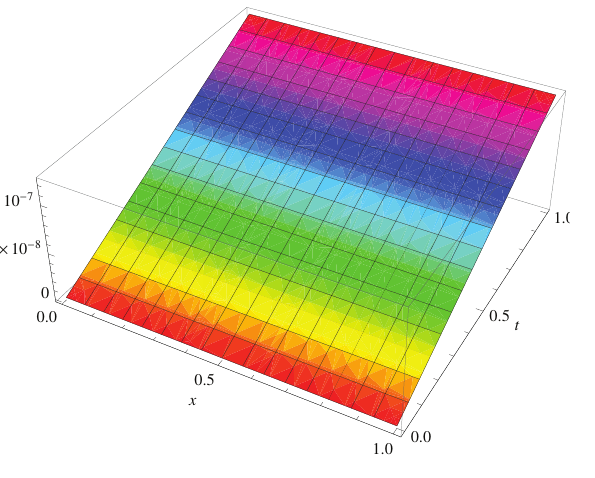
Fig. 7: Plot of absolute error E 3 = | u ( x , t ) − u 3 ( x , t ) | .